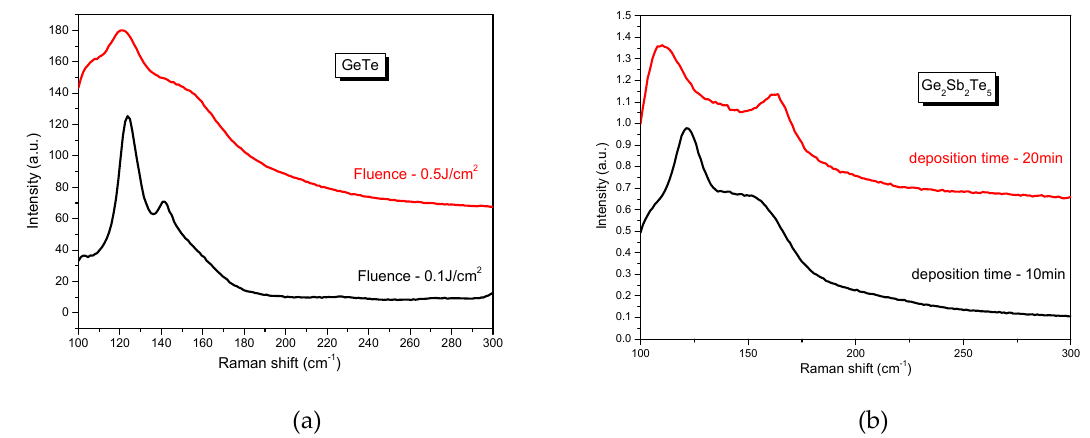
Figure 6. Raman spectra of the ( a ) GeTe and ( b ) Ge 2 Sb 2 Te 5 thin films deposited in different conditions by fs-PLD.